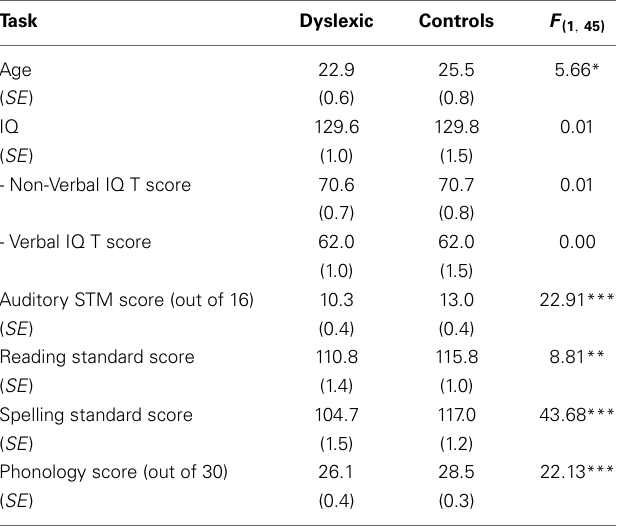
Table 1 | Group performance on standardized ability, literacy and phonological tests.